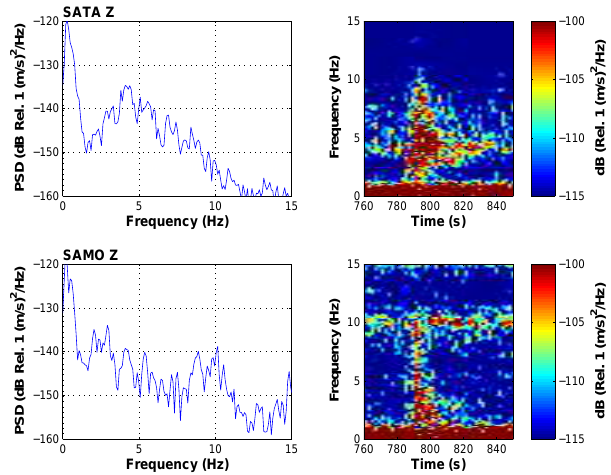
Fig. 15. Spectrogram (left), computed as in Fig. 6, of vertical com- ponent of ground velocity of a medium-frequency event recorded on 1 January 2012 at 00:12UTC by SATA (top) and SAMO (bot- tom) and a detailed view between 0 and 5Hz of the power spectra (right) of the